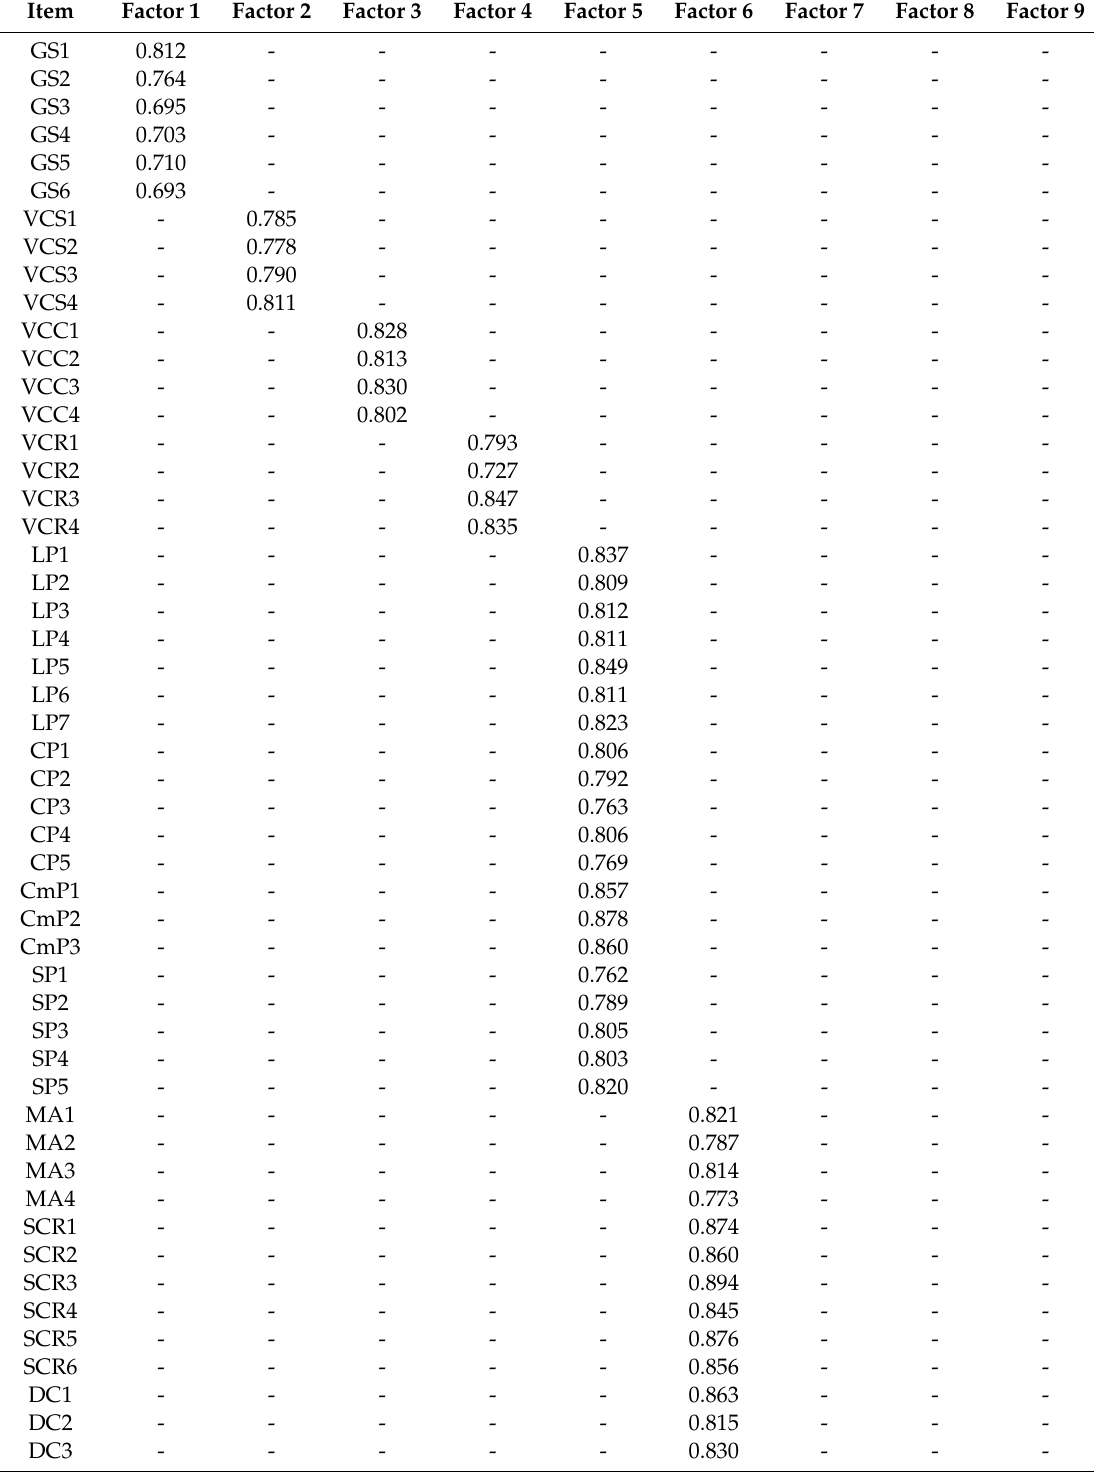
Table 2. Results of the exploratory factor